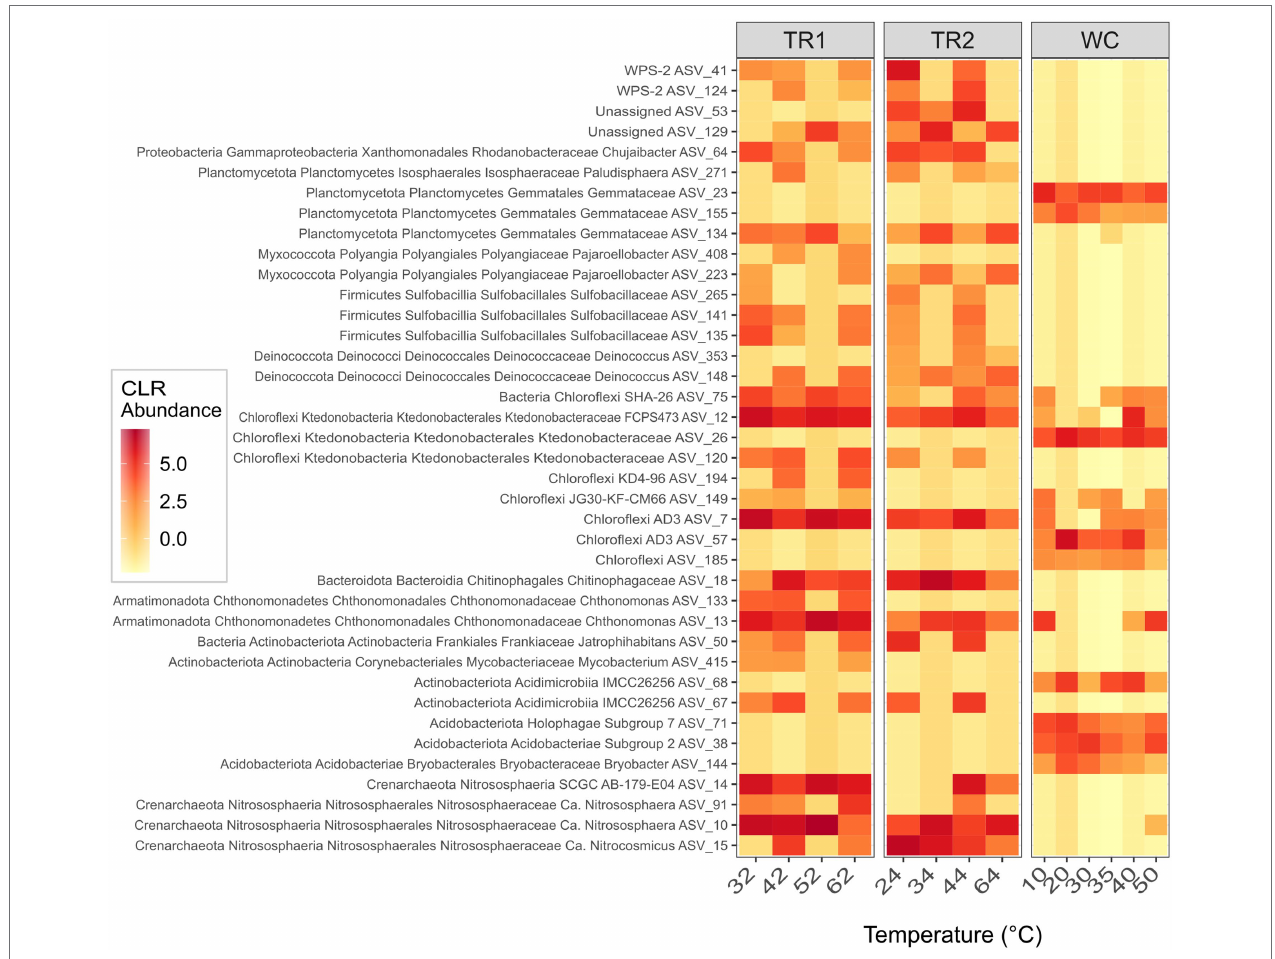
FIGURE 5 | Center log-ratio transformed (CLR) abundance data for the ASVs identified by the Random Forest algorithm as being most important (mean decrease in Gini value, MDG, > 0.06) for discriminating between the microbial communities at the three transects. ASVs are ordered by domain, then phylum, in ascending order. The lowest assignable taxonomic assignments are also given. The bottom four ASVs are Archaea, the rest are Bacteria. On the x-axis, samples are ordered by increasing temperature within each transect. TR1: Tramway Ridge transect 1; TR2: Tramway Ridge transect 2; WC: Western Crater transect; The full taxonomy of these ASVs is given in Supplementary Table 4